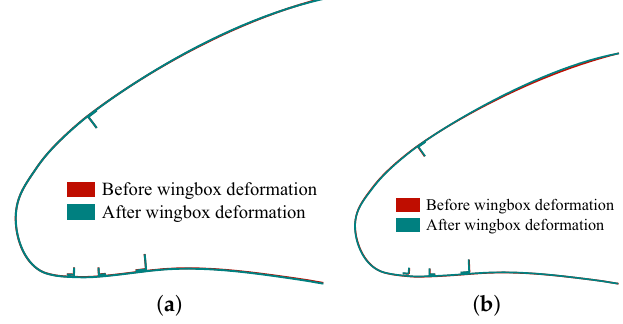
Figure 24. Cross section deformation shape at 25% ( a ) and 75% ( b ) of the leading edge